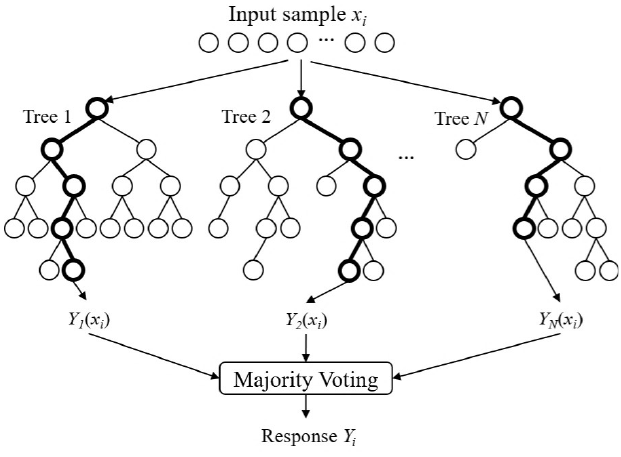
Figure 10. Diagram of RF